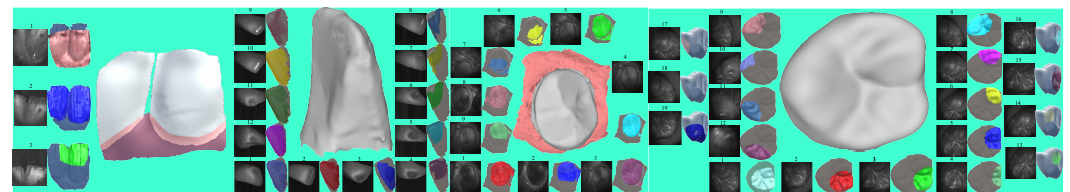
Figure 5. This shows the sequential reconstructed results of a side of a living incisor, an isolated incisor, an isolated premolar, and an isolated molar along with their depth responses in the designed scanning order, where green marks newly added points and blue marks the already existing points.